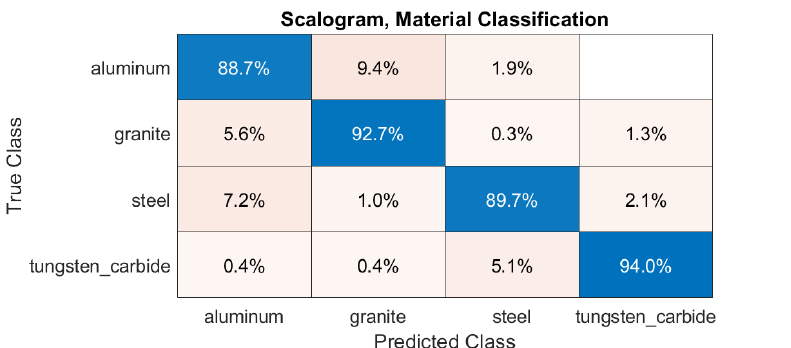
Figure 7. Confusion matrix for the CNN trained to classify material (aluminum, granite, stainless steel 347, or tungsten carbide) with the highest classification accuracy. The network was trained using the scalogram representation with a 20 dB SNR, resulting in a 90.91% average overall accuracy (Table 11). This network consisted of two convolutional layers with eight feature maps per layer (Table 6). The blue boxes indicate correct classification while the orange boxes indicate incorrect